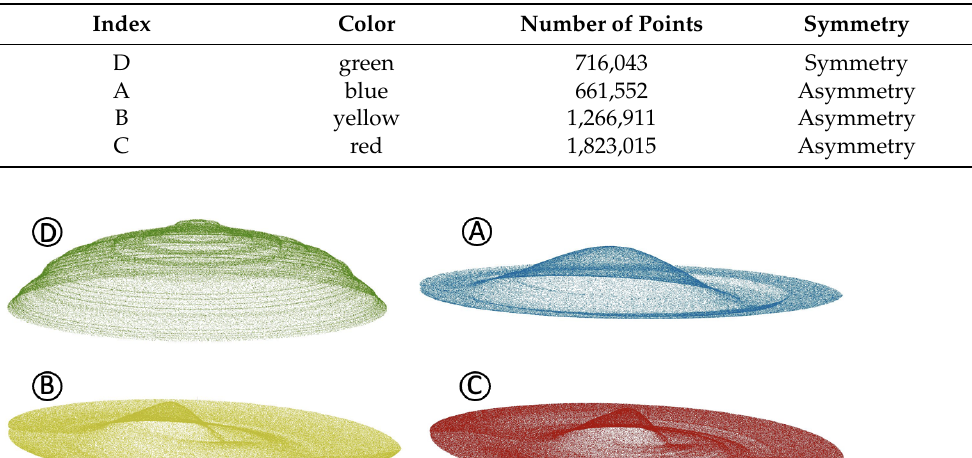
Figure 13. Digitization result of 75% of the first level of the Borobudur temple. Table 1. Number of points of each reconstructed point dataset.